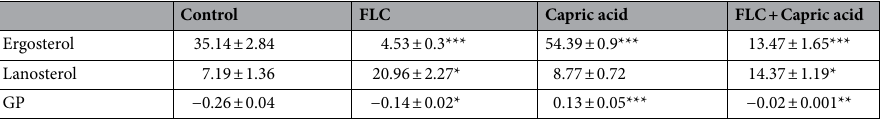
Table 1. Sterols (μg/mg dry mass of isolated PM lipids, means ± SD, n = 3) in C. albicans CAF2-1 grown for 8 h in the following conditions: control without antimicrobial agents; FLC—treated with fluconazole 4 μg/mL; Capric acid—treated with capric acid 45.3 μg/mL; FLC + Capric acid—simultaneously treated with fluconazole 4 μg/mL and capric acid 45.3 μg/mL. General polarization values (GP; means ± SD, n = 6) of Laurdan incorporated into PMs of C. albicans CAF2-1 grown for 8 h with antimicrobial agent(s). Statistical analysis was performed by comparing cells treated with antimicrobial agent(s) with the corresponding untreated controls (* p < 0.05; **p < 0.01; *** p < 0.001).